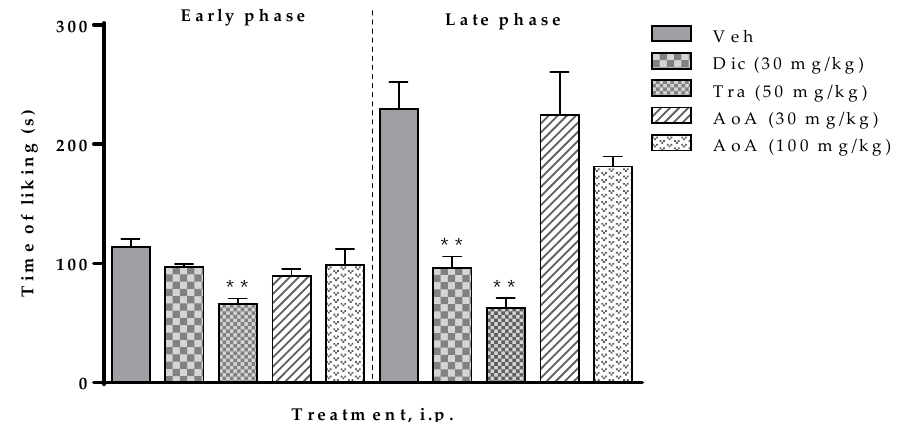
Figure 3. Effect of the aqueous extract of Aristolochia odoratissima (AoA, 30 and 100 mg/kg, i.p.) in the formalin test (2.5%, 25 µL/paw) in mice. The data are expressed with the mean ± sem. One-way ANOVA + Dunnett test, * p < 0.05 and ** p < 0.001. Veh: Vehicle; Dic: Diclofenac, Tra: Tramadol.